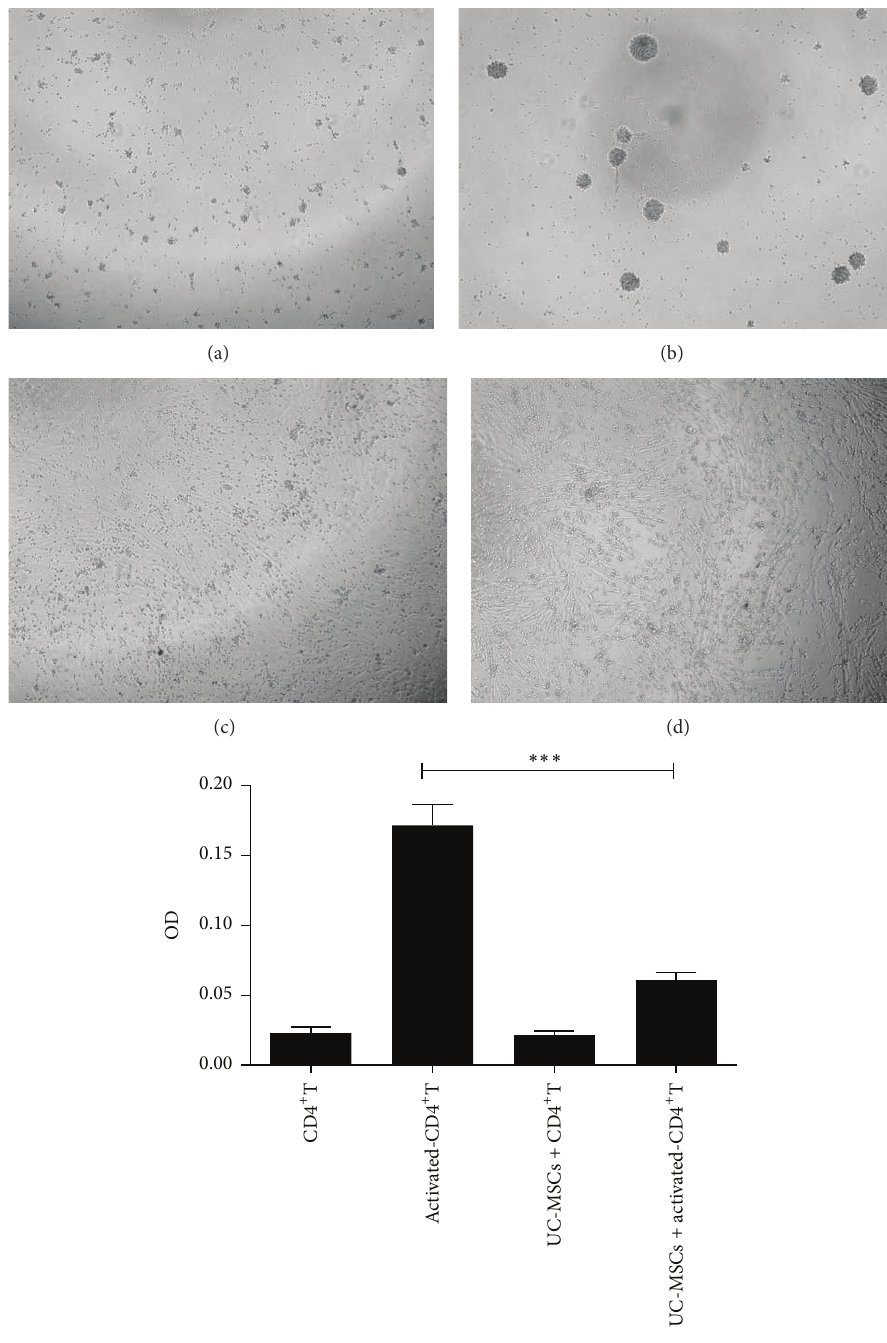
Figure 3: UC-MSCs suppressed proliferation of CD4 + T cells. (a) Nonactivated CD4 + T cells; (b) activated CD4 + T cells; (c) cocultured nonactivated CD4 + T cells with UC-MSCs; (d) cocultured activated CD4 + T cells with UC-MSCs; magnification: 40x; (e) proliferation was evaluated by MTS. Data represent one of the three independent experiments, each performed in triplicate. ∗∗∗ 𝑃 < 0.001